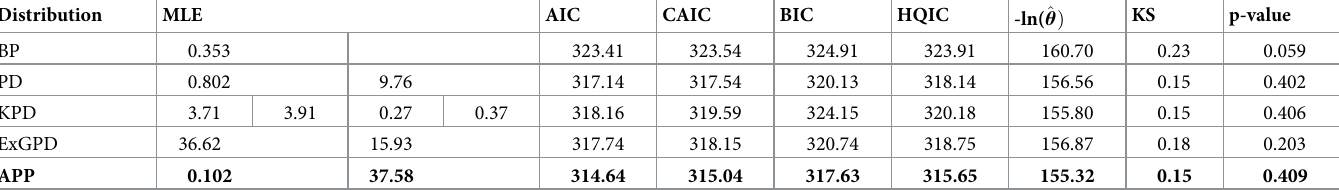
Table 4. Goodness of fit result for data set 2.